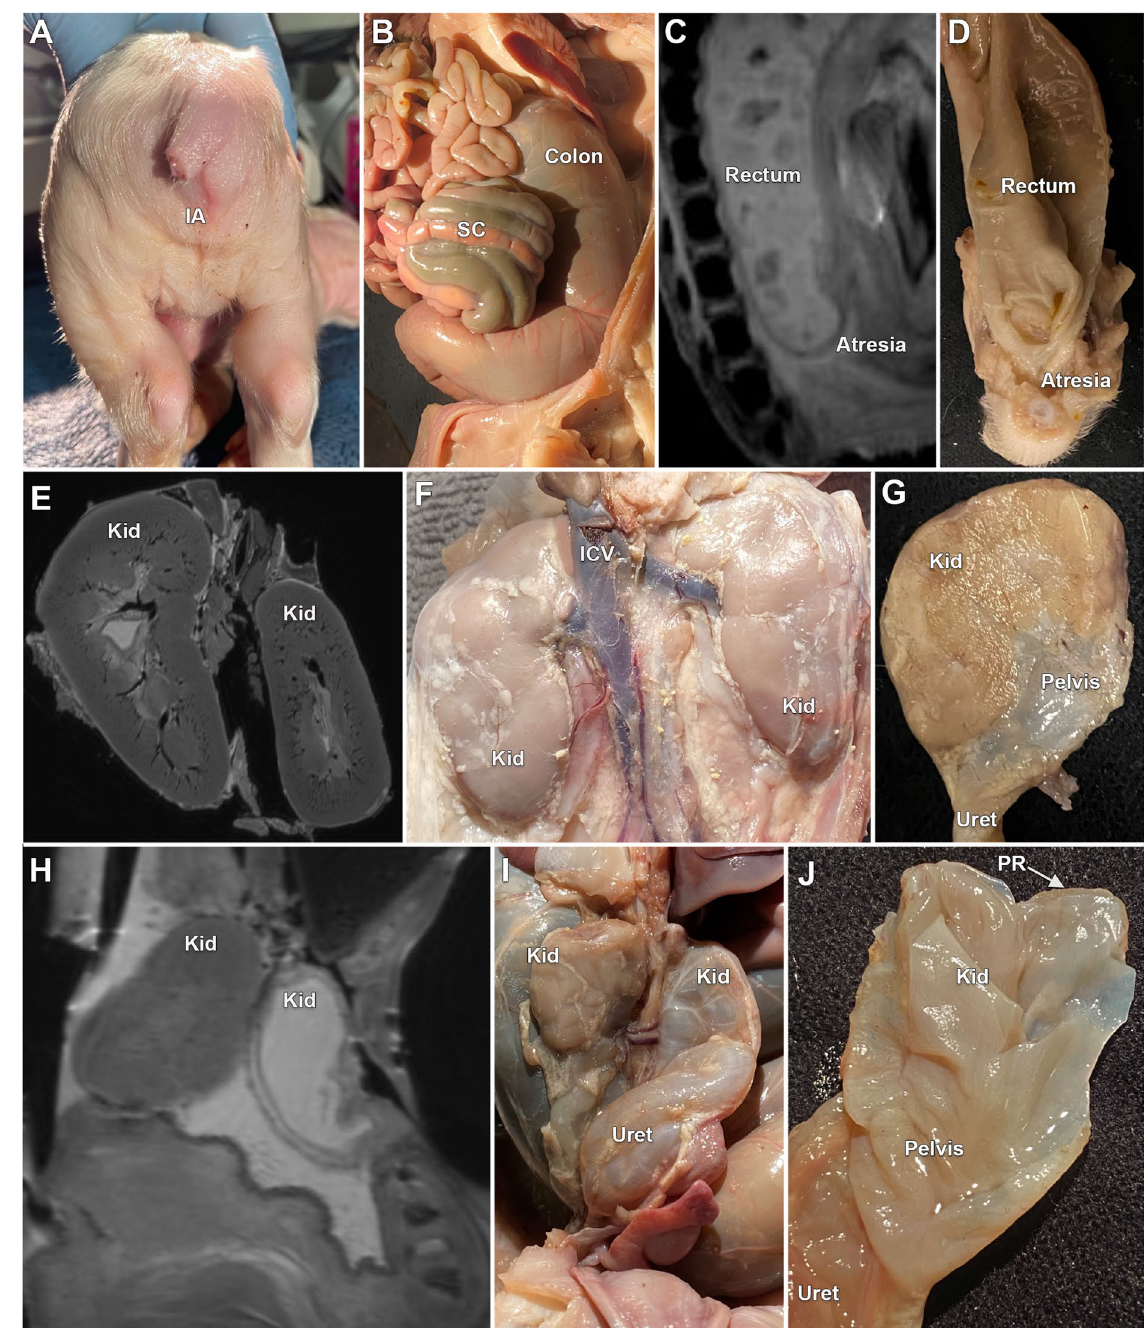
Figure 7. MRI and gross images of the malformations identified in a mutant SAP130 term pig. Image ( A ) shows the anal region showing the imperforate anus. Most of the tail has been removed. The in situ gross image of the abdomen shows the distended colon ( B ). A sagittal MRI ( C ) shows the distended colon and rectum and the site of the atresia, and ( D ) is the gross dissection of the atretic rectum. Image ( E ) is an MRI of normal (wild type) kidneys and ( F ) shows the gross appearance of normal pig kidneys. Illustration ( G ) is the cut surface of hypoplastic kidney found in the mutant pig. An MRI of the mutant pig kidneys ( H ) shows one hypoplastic kidney and one hypoplastic kidney with severe hydronephrosis with a hydroureter. Image ( I ) shows the gross appearance of the hypoplastic kidneys with the one kidney showing hydronephrosis with a hydroureter. The opened hypoplastic and hydronephrotic kidney of the mutant ( J ) showing the severe hydronephrosis with the loss of renal architecture with only a narrow rim of renal parenchyma identified. IA-Imperforate anus, SC-Spiral colon, ICV-Inferior caval vein, Kid-Kidney, Uret-Ureter, RP-Renal